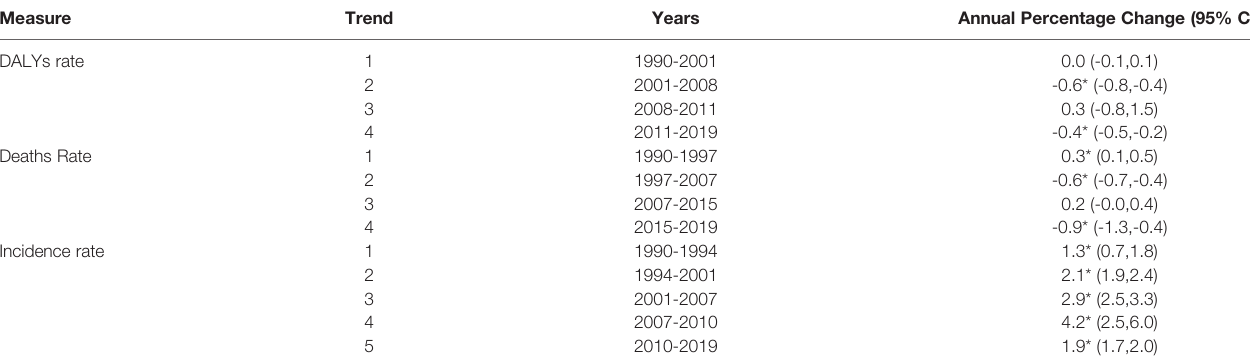
TABLE 2 | Trends in age-standardized incidence rate, death rate and DALYs rate for China, 1990 – 2019. Measure